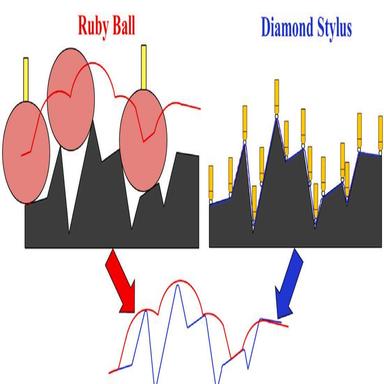
Comparison between the traversed profile of a large spherical stylus (left) and a small radius stylus (right).